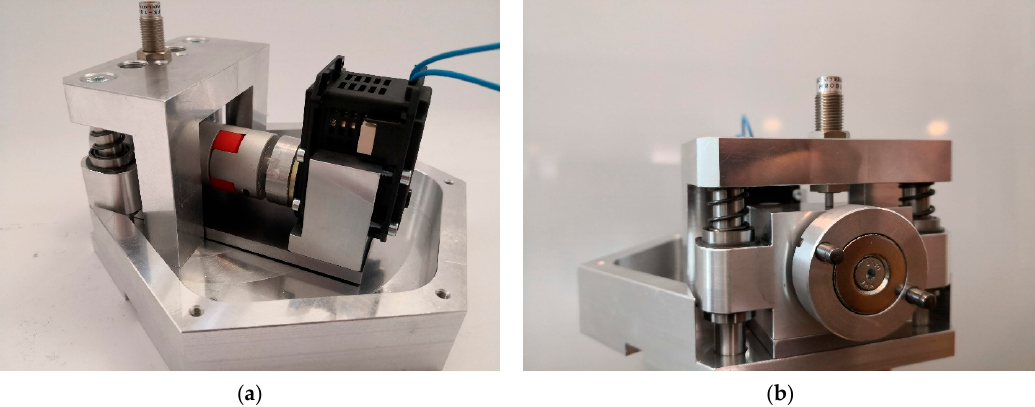
( b ) Figure 5. Drive wheel module of the modular mobile robot (3D model). ( a ) External view. ( b ) Inter- nal view.